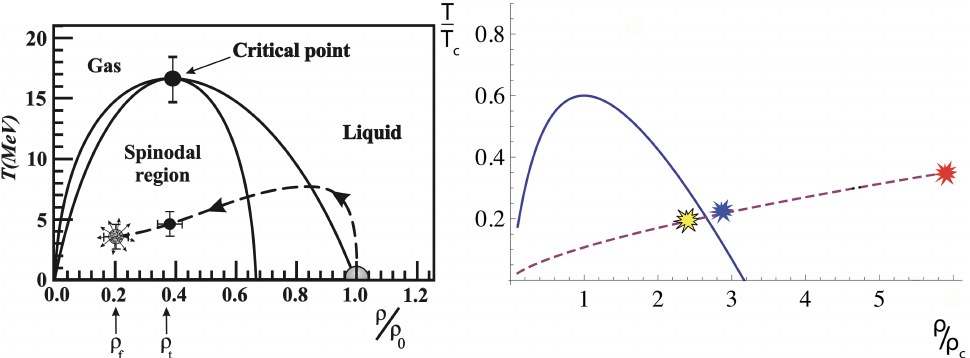
Figure A3. Left Panel : From Ref. [73]: Experimental data and analysis of fragmentation in p ( 8.1 GeV ) + Au collisions, and proposed spinodal region for the nuclear system. The arrow line shows the path of the system from the starting point at T = 0 and ρ 0 to the multi-scission point at ρ f . Points ρ t and ρ f denote the partition and freeze-out configurations. Right Panel: Red, blue, and yel- low stars represent stages of stellar-fragment evolution: red—”hot” state after its birth, blue—”cool” (stable) state near the spinodal zone boundary, yellow—”nuclear-fog” (explosive) state. Adiabatic line θ = θ 0 ( z / z 0 ) 2/3 is drawn to guide the eye. The actual path is more complex than an